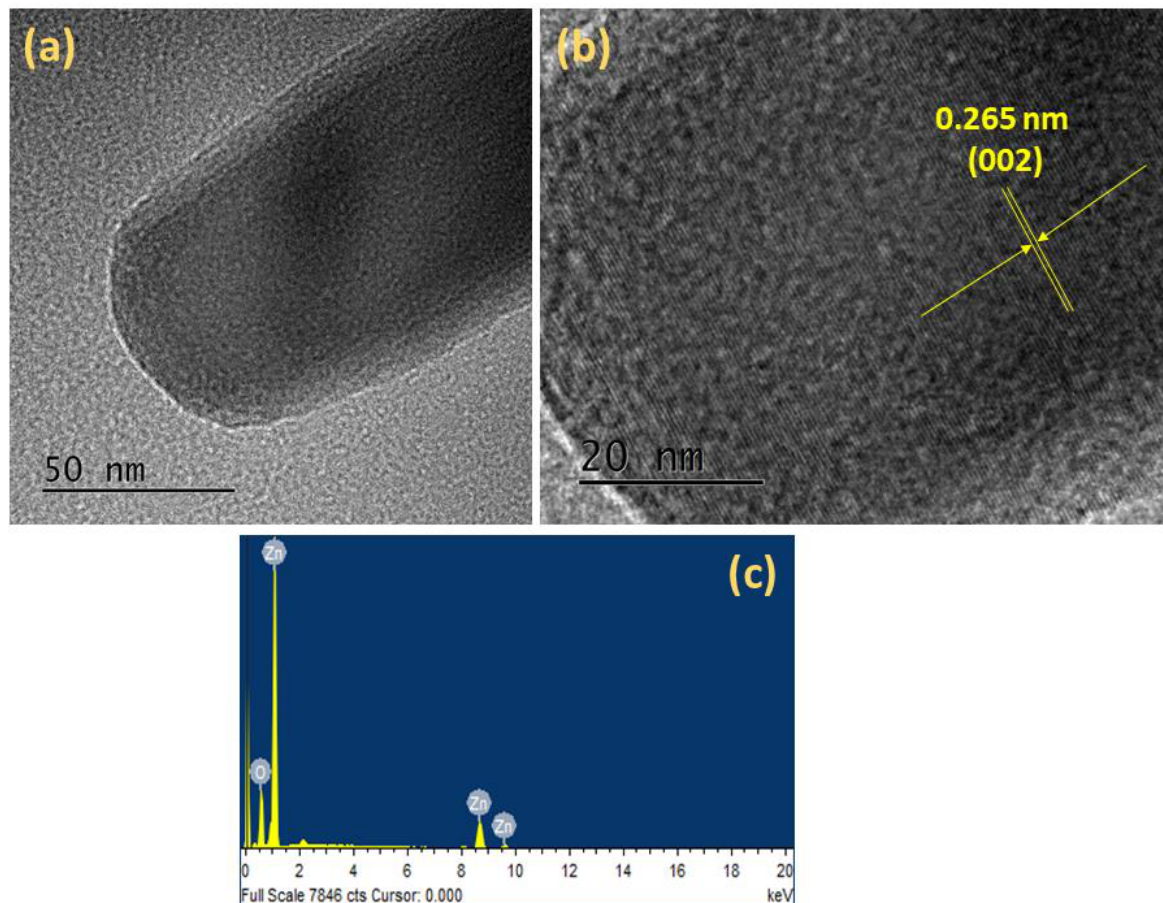
Figure 6. ( a ) TEM image, ( b ) HRTEM image, and ( c ) EDX spectrum of ZnO prepared at 85 °C.